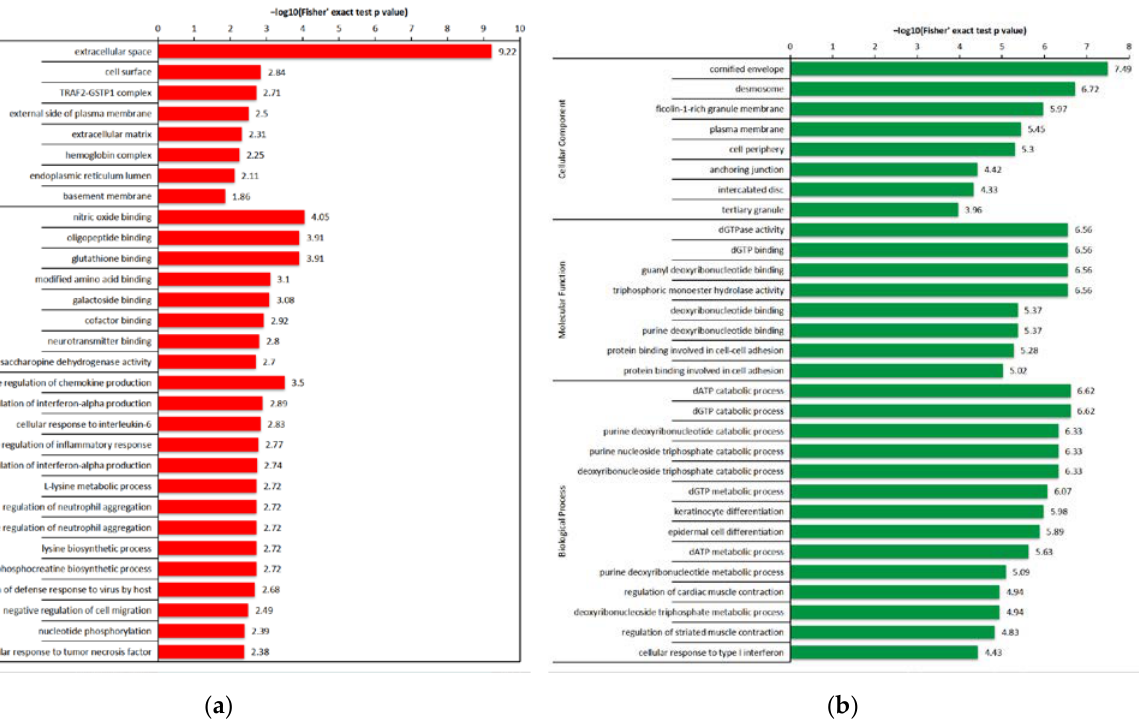
Figure 6. GO enrichment analysis of the DEPs: ( a ) GO enrichment analysis of the up-regulated proteins; ( b ) GO enrichment analysis of the down-regulated proteins.